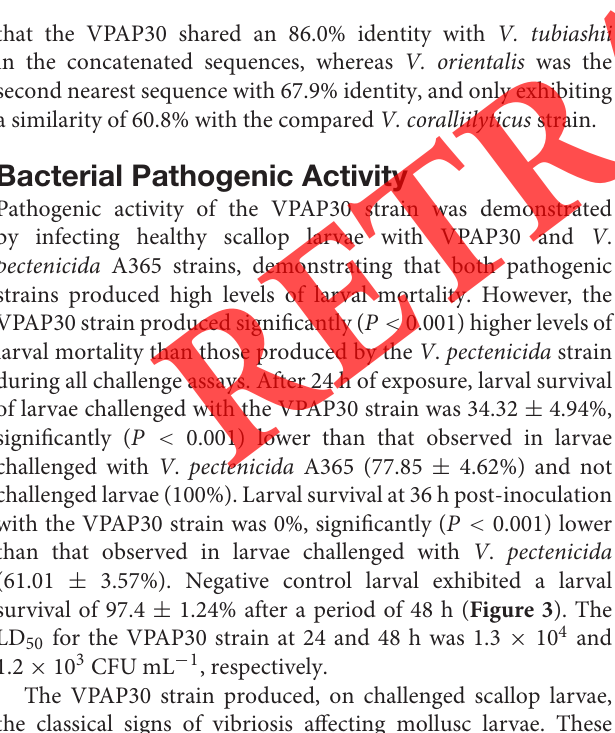
FIGURE 1 | Phylogenetic tree based on 16S rRNA gene sequence constructed by the neighbor-joining method. Photobacterium damselae was used as an outgroup. Horizontal branch lengths are proportional to evolutionary divergences. Bootstrap values from 1,000 replicates appear next to the corresponding branch.